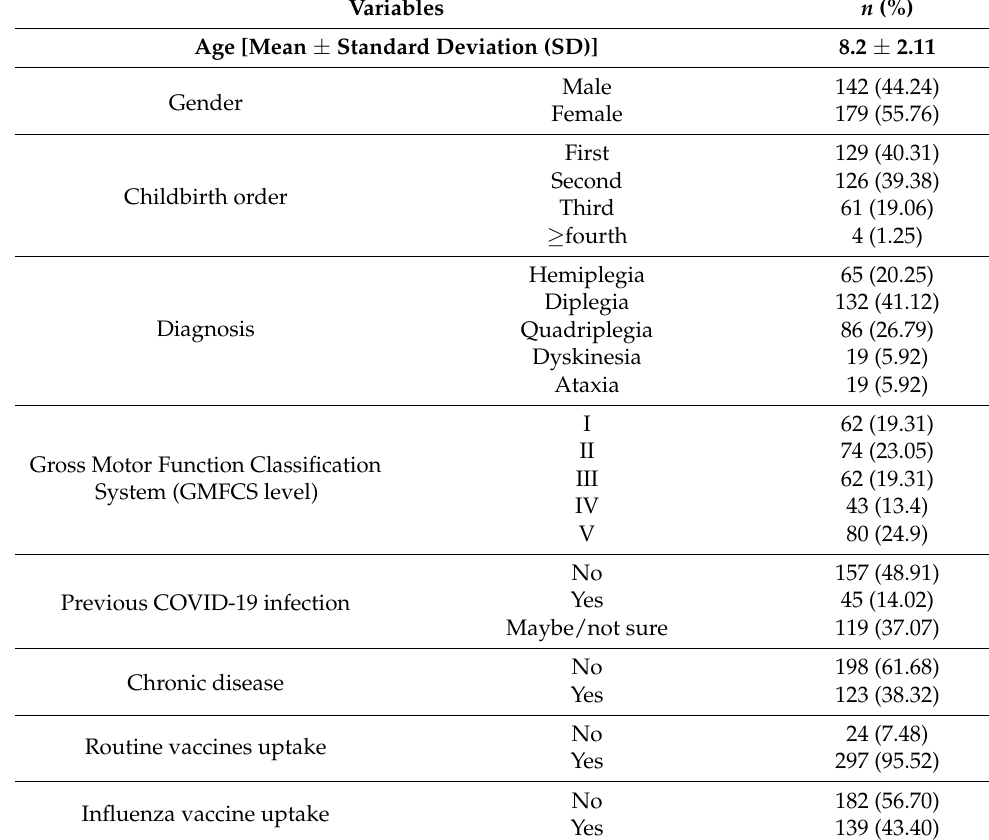
Table 2. Characteristics of the children ( n = 321).